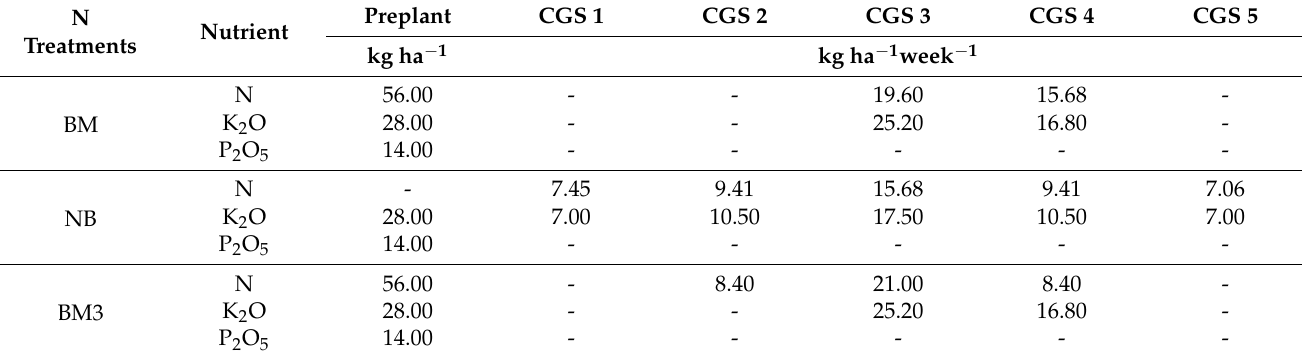
Table 4. Weekly nutrient applications at each crop growth stage (CGS) during spring and fall seasons of 2018. Preplant CGS N Nutrient Treatments